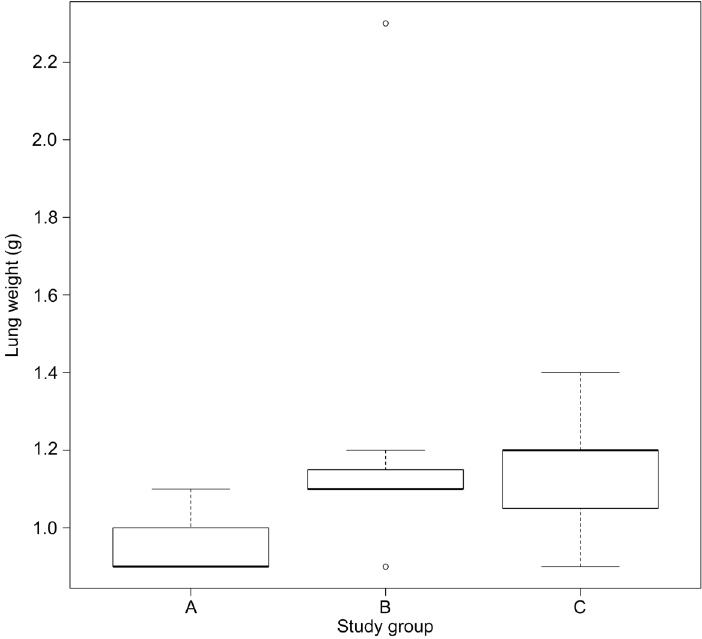
Figure 2. Box-plot of lung weight according to the study groups. Group A, ventilated with a positive end-expiratory pressure (PEEP) of 2 cmH 2 O; Group B, with a PEEP of 5 cmH 2 O, and Group C, with a PEEP of 10 cmH 2 O. Data are reported as medians and interquartile